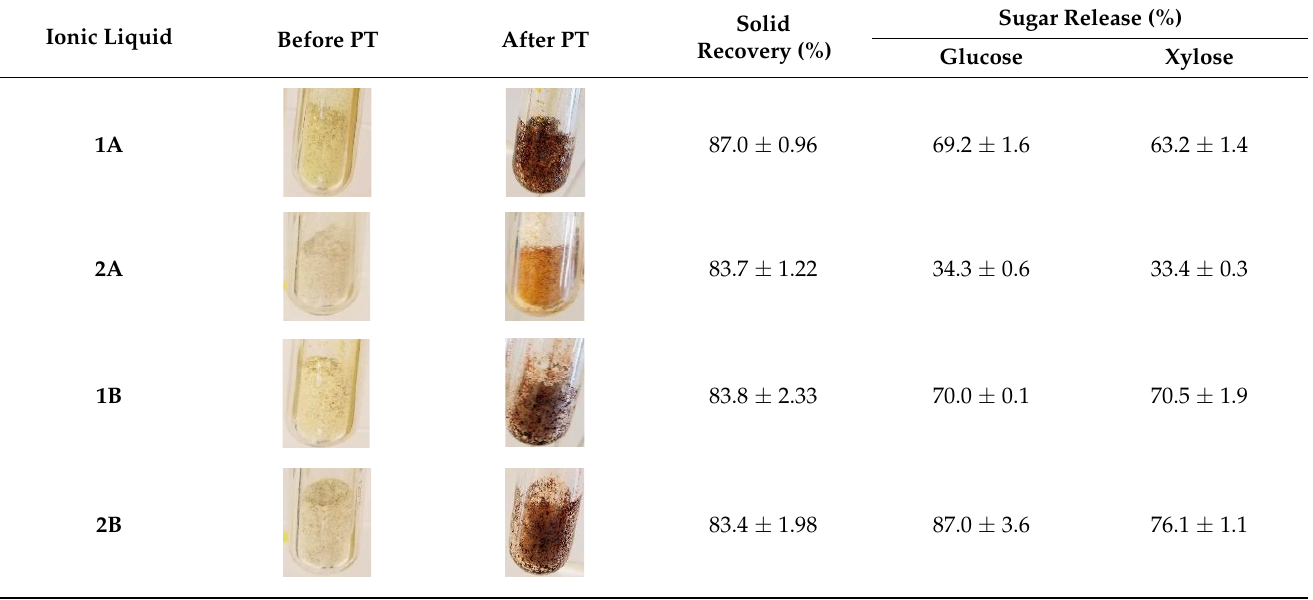
Table 1. Pretreatment efficacy of Schiff base ILs on sorghum biomass + .